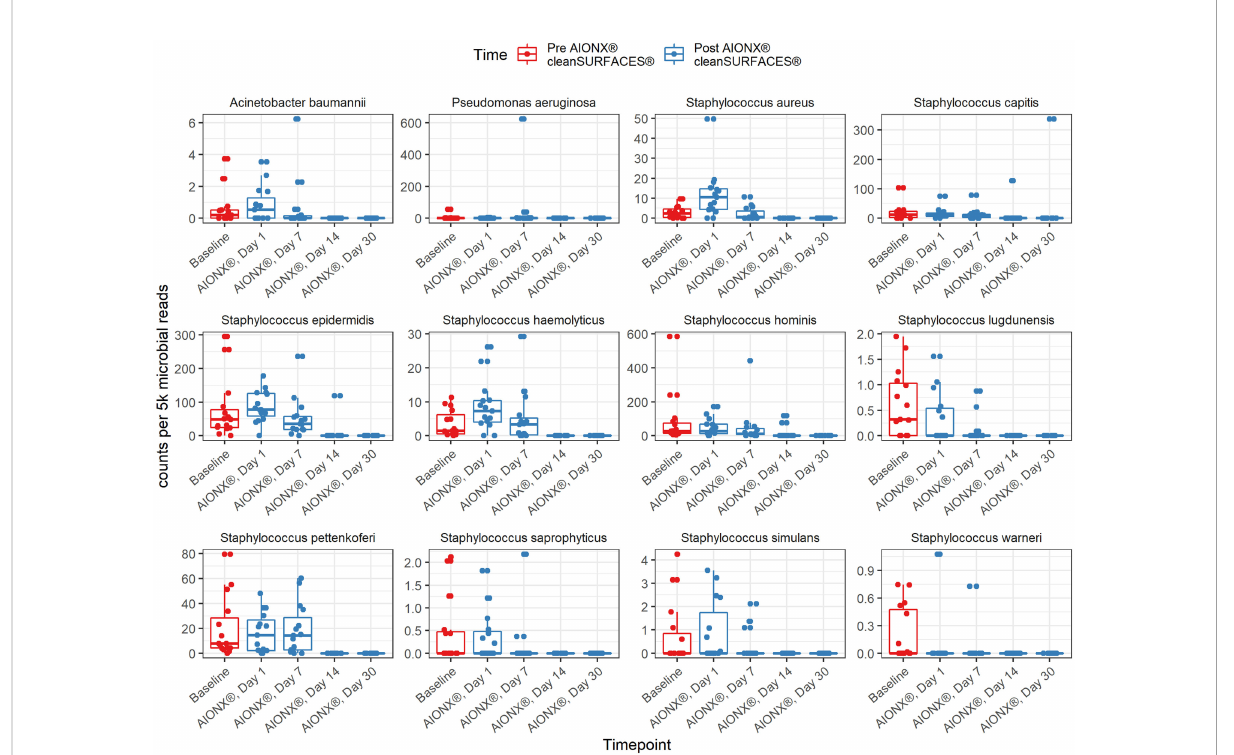
FIGURE 4 Normalized counts of species associated with Hospital Acquired Infections, during cleanSURFACES ® intervention.